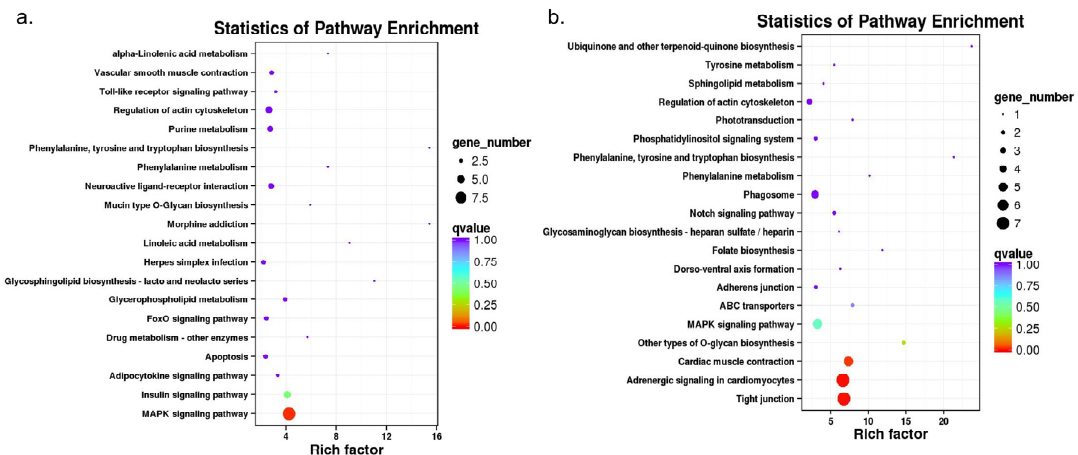
Figure 4. Kyoto Encyclopedia of Genes and Genomes (KEGG) pathway enrichment of the DEGs in up-regulation ( a ) and down-regulation ( b ) of genetic responses to hypoxia stress in bighead carp. The size of colored dots represents the number of significant DEGs associated with each corresponding